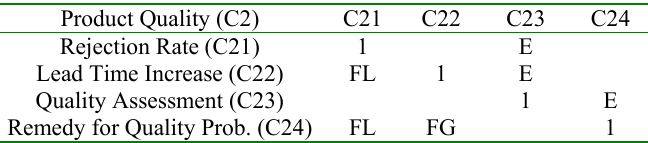
Table 8. Linguistic evaluation matrix of DM1 for C2 sub-criteria